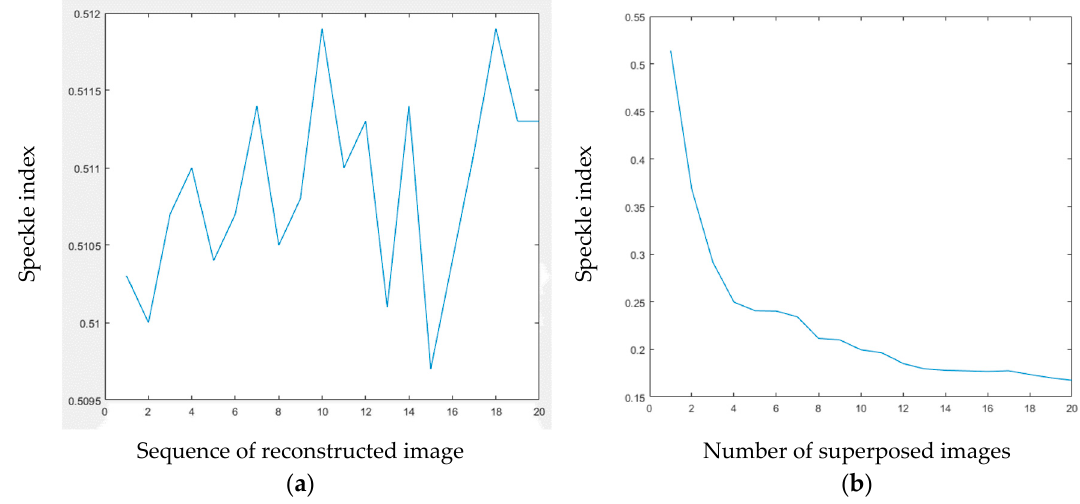
Figure 10. ( a ) Speckle index (SI) of reconstructed image from single hologram calculated by different random phases. ( b ) SI of superposed reconstructed images from different number of holograms.